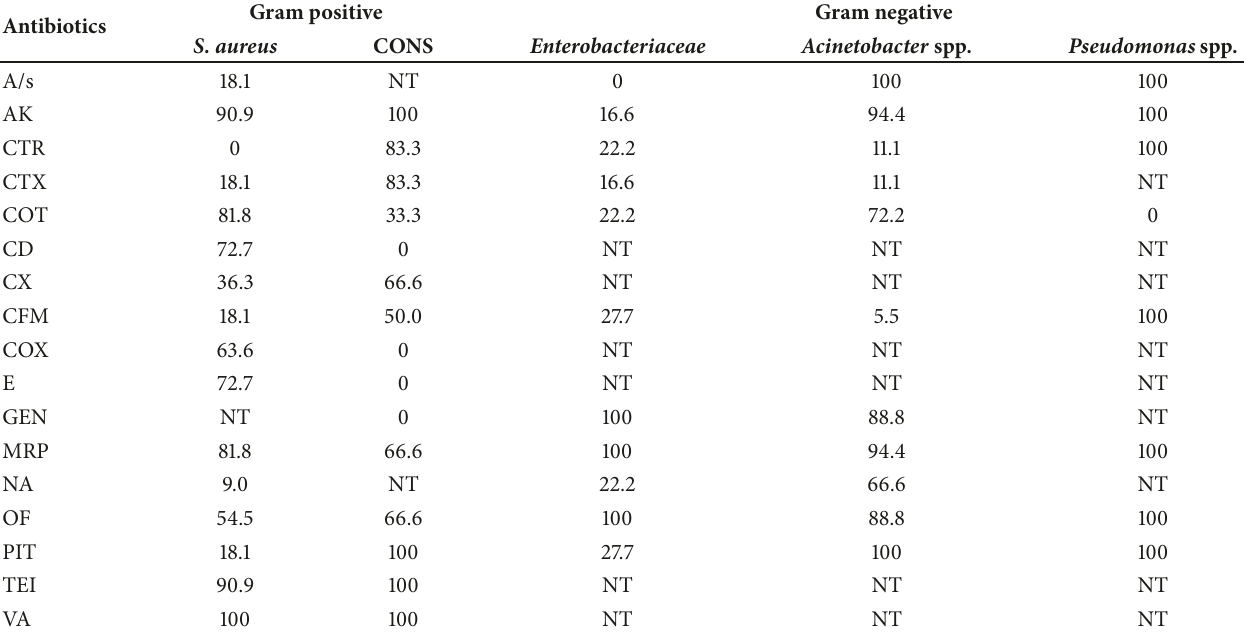
Table 3: Antibiotic sensitivity profile of gram-positive and gram-negative